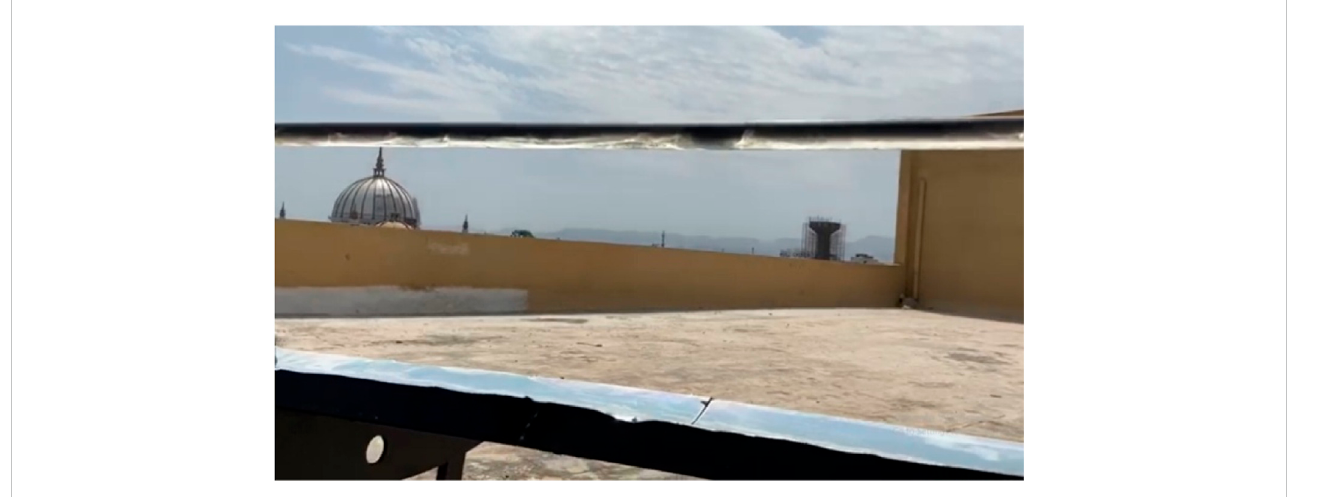
FIGURE 7 Actual image of solar fl ux distribution on the receiver tube.